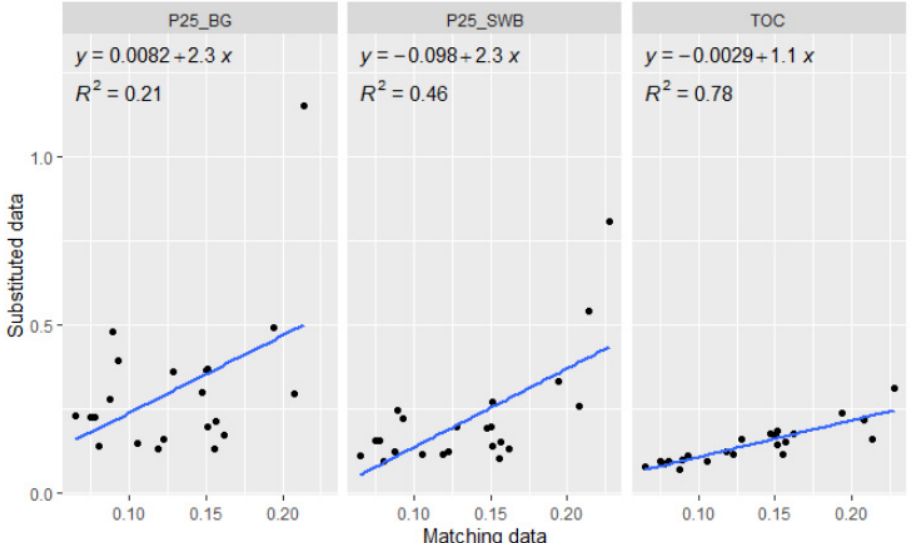
Figure 12. The comparison of the PNEC Pro calculated RCR for Pb between the matching data and substituted data (P25_BG—the 25th percentile of the available DOC data and/or the DOC data calculated by the TOC from the Bulgarian monitoring network results during 2020; P25_SWB—the 25th percentile of the DOC data calculated by the TOC for the respective water body; TOC—the matching DOC data calculated by TOC).